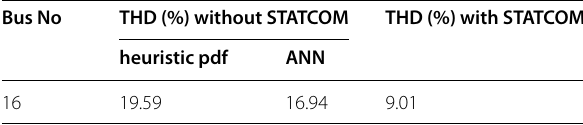
Table 26 THD of real power flow with and without STATCOM of